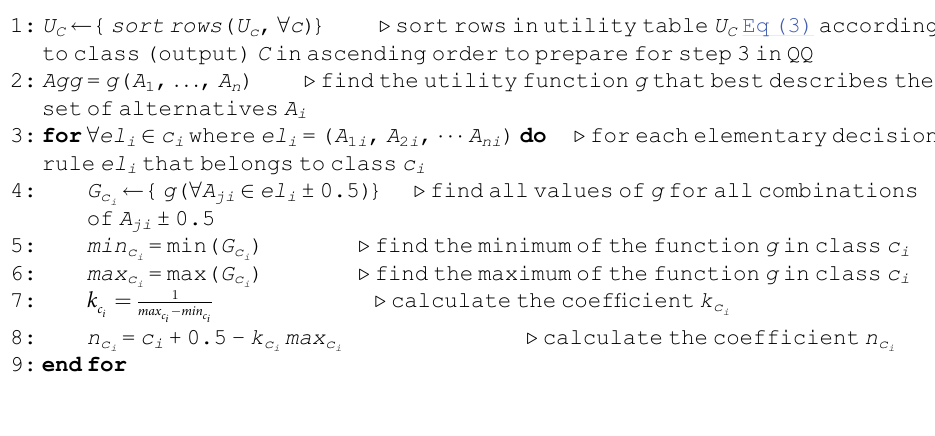
Algorithm 1 Algorithm steps 2 and